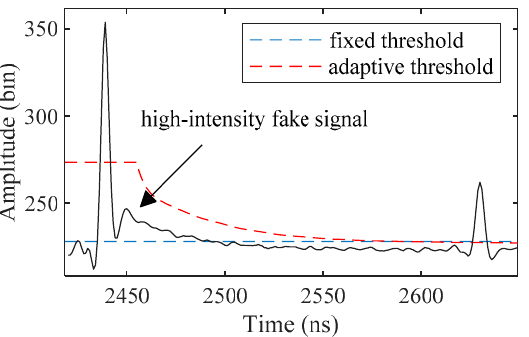
Figure 8. Thresholds used in signal detection. The high-intensity fake signals are located in water